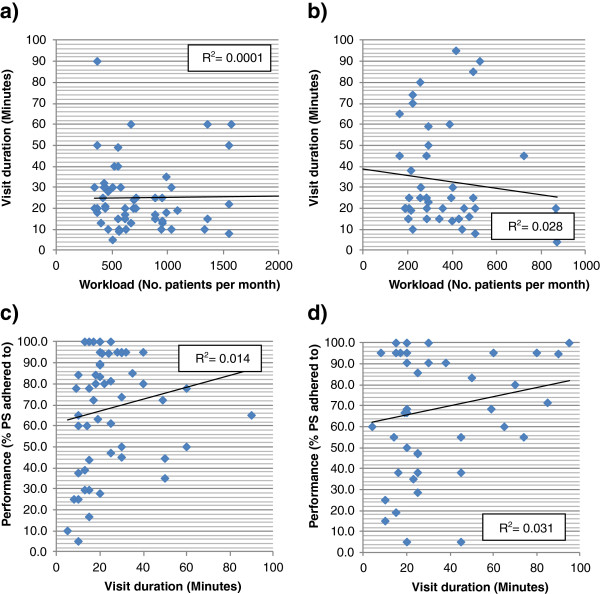
Correlation of the workload and the duration of the visits per staff (Figure 4a [clinicians] and 4b [counsellors]), and correlation of the duration of the visits and performance per staff (Figure 4c [clinicians] and 4d [counsellors]). Each dot (♦) represents a particular visit; R2: correlation coefficient; PS: performance standards.